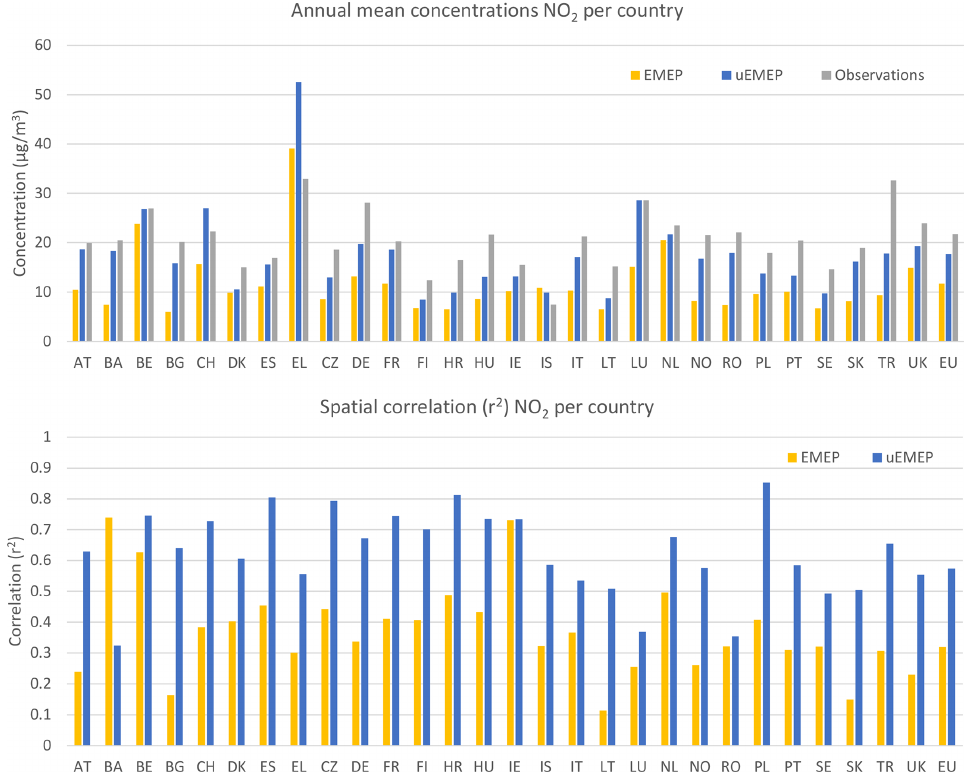
Figure 7. Annual mean NO 2 concentrations and spatial correlation (coefficient of determination r 2 ) per country for 2018 calculated with the EMEP model and uEMEP compared to AIRBASE observations. Only countries with 10 or more stations are shown, but all stations are included in the final EU result. A total of 3313 stations are included in the